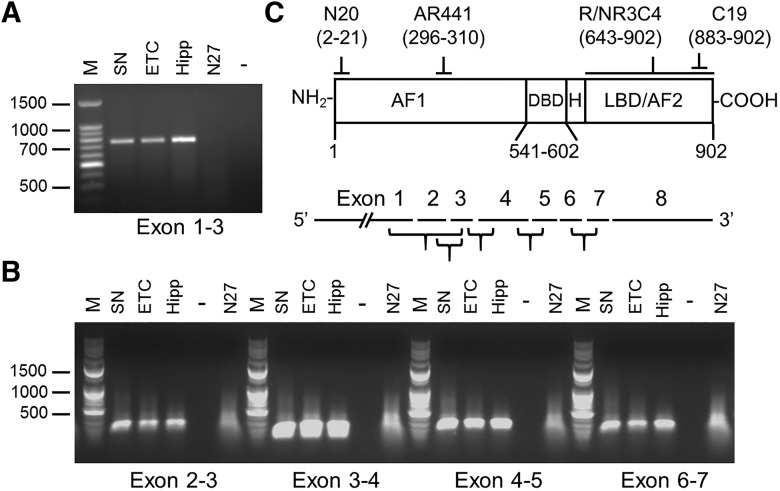
Androgen receptor RT-PCR. Intron-spanning primer sets for rat AR were used to amplify cDNA from young intact male rat substantia nigra pars compacta (SN), 2nd layer of the entorhinal cortex (ETC), CA1 region of the hippocampus (Hip), and N27 cells (A and B). Note the lack of amplification product for the 3′ region of AR in N27 cells (A). C, Targets of the antibodies used to detect AR and their epitopes in parentheses aligned with the AR domain structure (top), and the relative amplification product locations in the AR mRNA (bottom). Exons 2 and 3 code for the DBD. M denotes a 100-bp DNA ladder, and negative controls are marked with –.